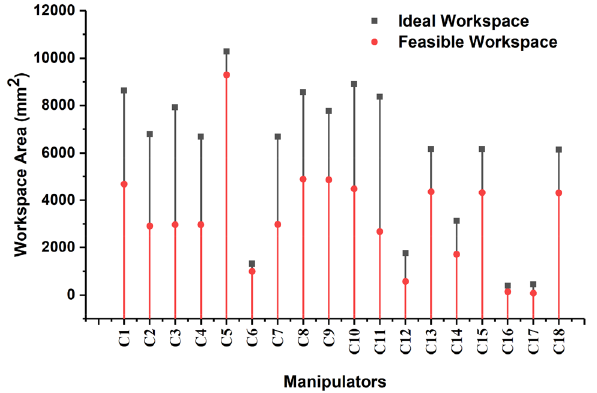
Fig. 10 Ideal and feasible workspace area of manipulators